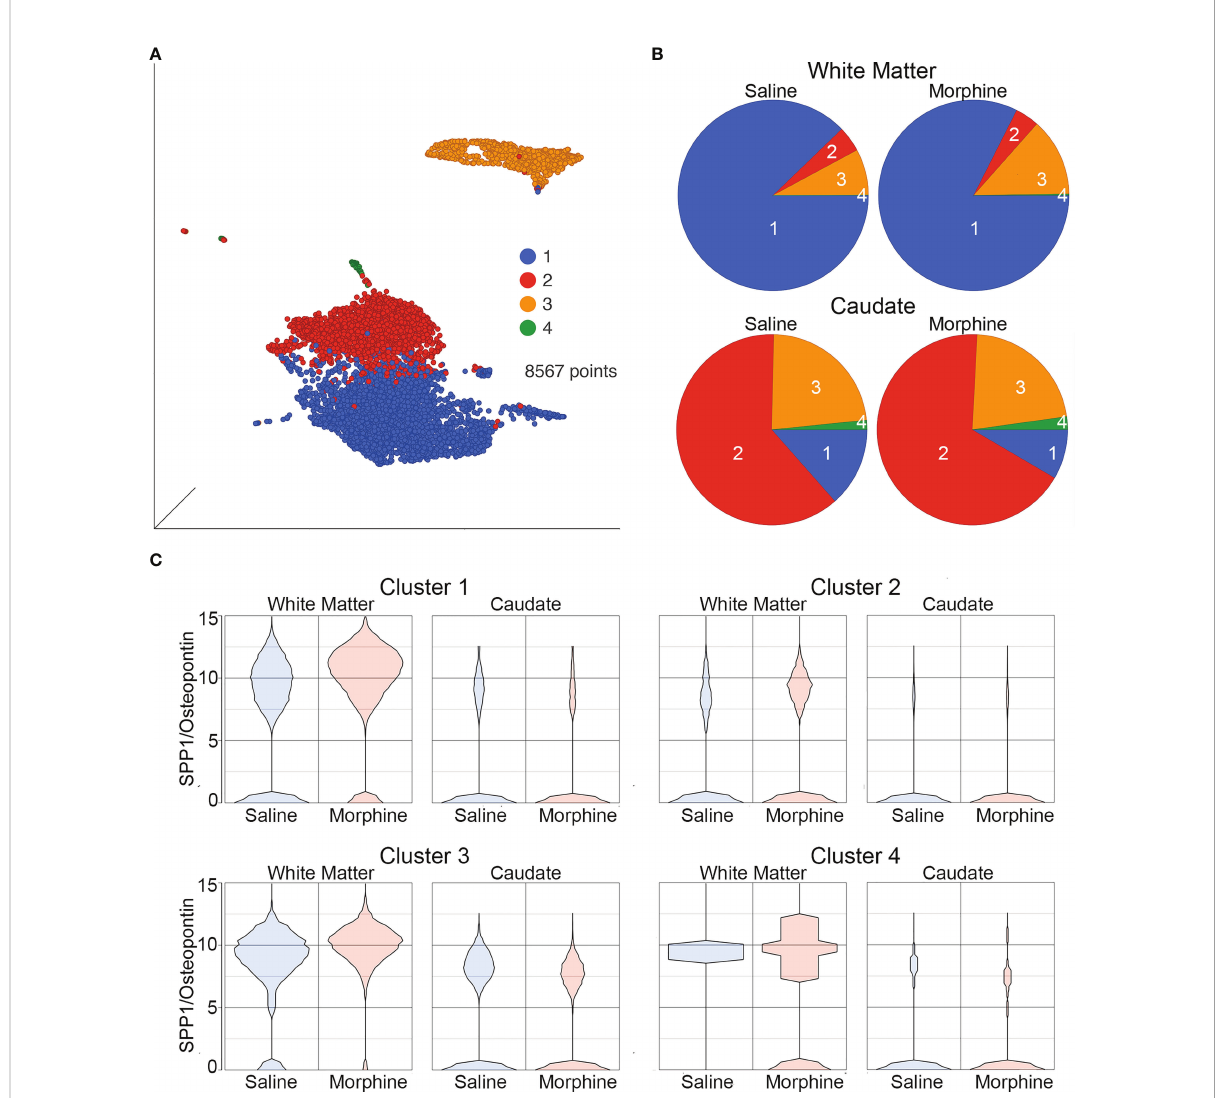
FIGURE 7 Microglia in White Matter and Caudate. (A) UMAP with graph-based clustering of microglia identi fi ed from the white matter and caudate microglia clusters. (B) Pie charts with areas proportional to the percentage of cells in each treatment condition from the different graph-based clusters of microglia in the white matter and caudate. (C) Violin plots of SPP1/osteopontin expression in microglia in the different clusters, separated by location and treatment. Values on the Y-axis are the least-square mean expression (log 2